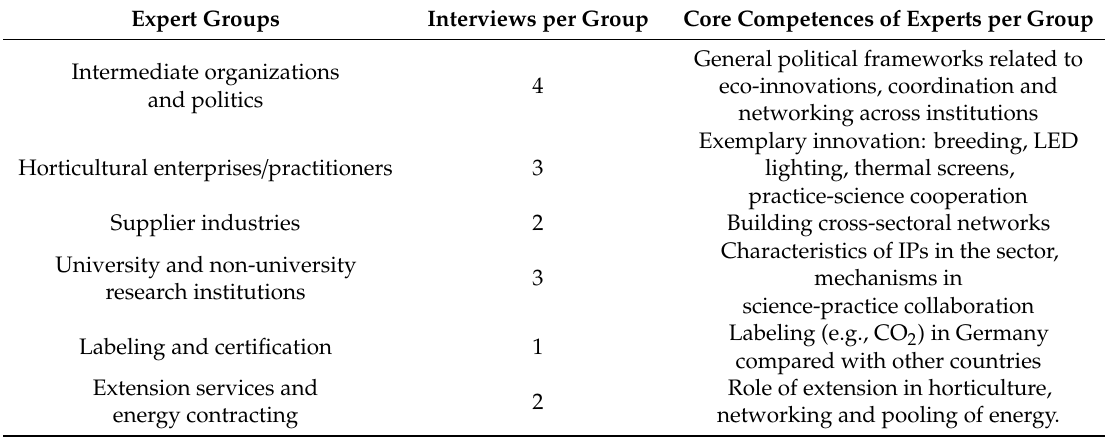
Table 1. Interviewed expert groups and their fields of